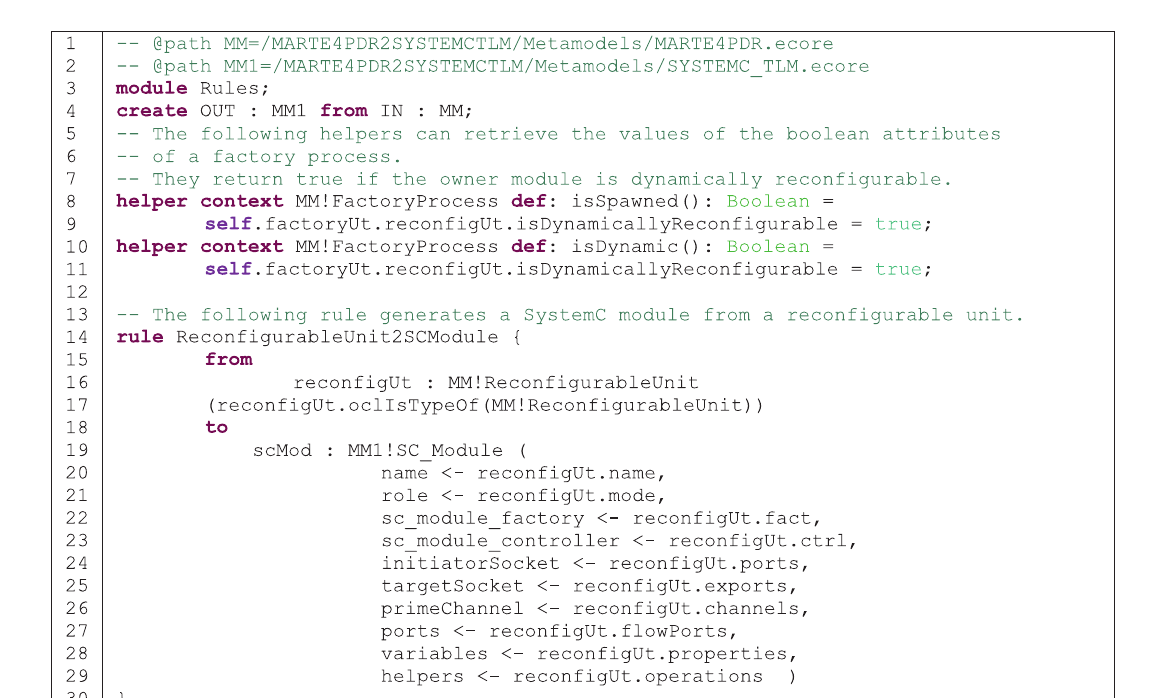
Figure 20: Fragment of the ATL transformation